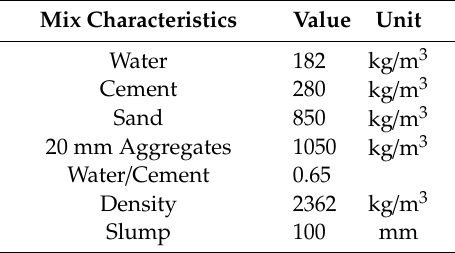
Figure 7. Pull-out test setup to evaluate the bond strength of bamboo composite reinforcement to concrete. Table 2. Concrete mix proportions.